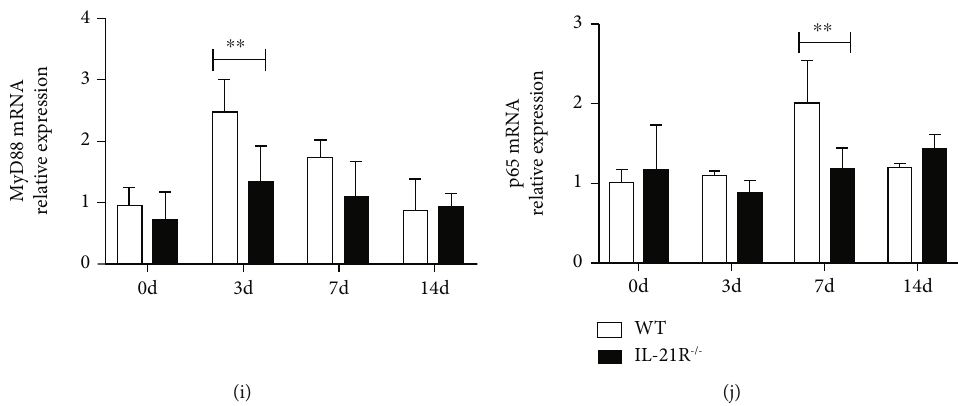
Figure 3: Pulmonary chemokines, cytokines, and TLR/MyD88 signal of IL-21R -/- mice in response to Chlamydia muridarum ( C. muridarum ) lung infection. Following C. muridarum infection, mice were euthanized at days 0, 3, 7, and 14 and lungs were harvested for mRNA expression analysis. Total RNA was extracted from pulmonary tissues of wild-type (WT) and IL-21 receptor de fi cient (IL-21R -/- ) mice, and the mRNA expression of chemotactic factors (a – f) KC, MIP-2, CXCR2, IL-6, IL-1 β , and TNF- α as well as (g – j) TLR/MyD88/NF- κ B pathway mediators TLR2, TLR4, MyD88, and p65 was measured by quantitative real-time PCR (qPCR). Data are represented as means ± SD from n = 3 – 4 per group, representative one of three independent experiments. Statistical signi fi cances of di ff erences are determined by two-way ANOVA followed by Bonferroni ’ s multiple comparisons test. ∗ P < 0 : 05 , ∗∗ P < 0 : 01 , ∗∗∗ P < 0 : 001 , and ∗∗∗∗ P < 0 : 0001